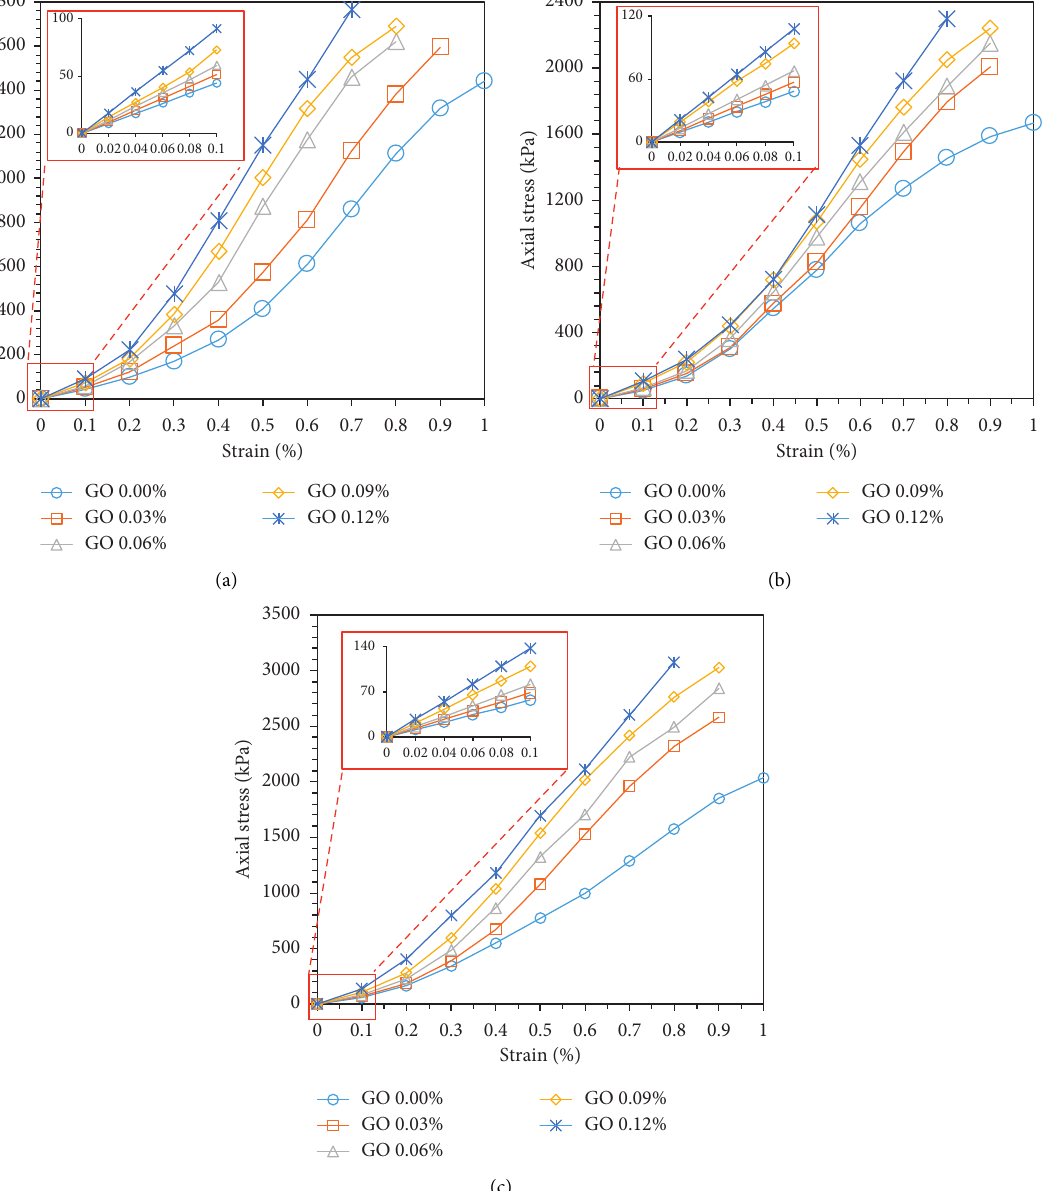
Figure 7: Effect of GO on compressive stress-strain behavior of the loess samples for 7d (a), 14d (b), and 28d